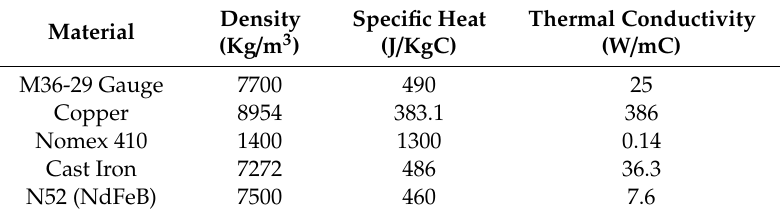
Table A2. Thermal properties of the material used.